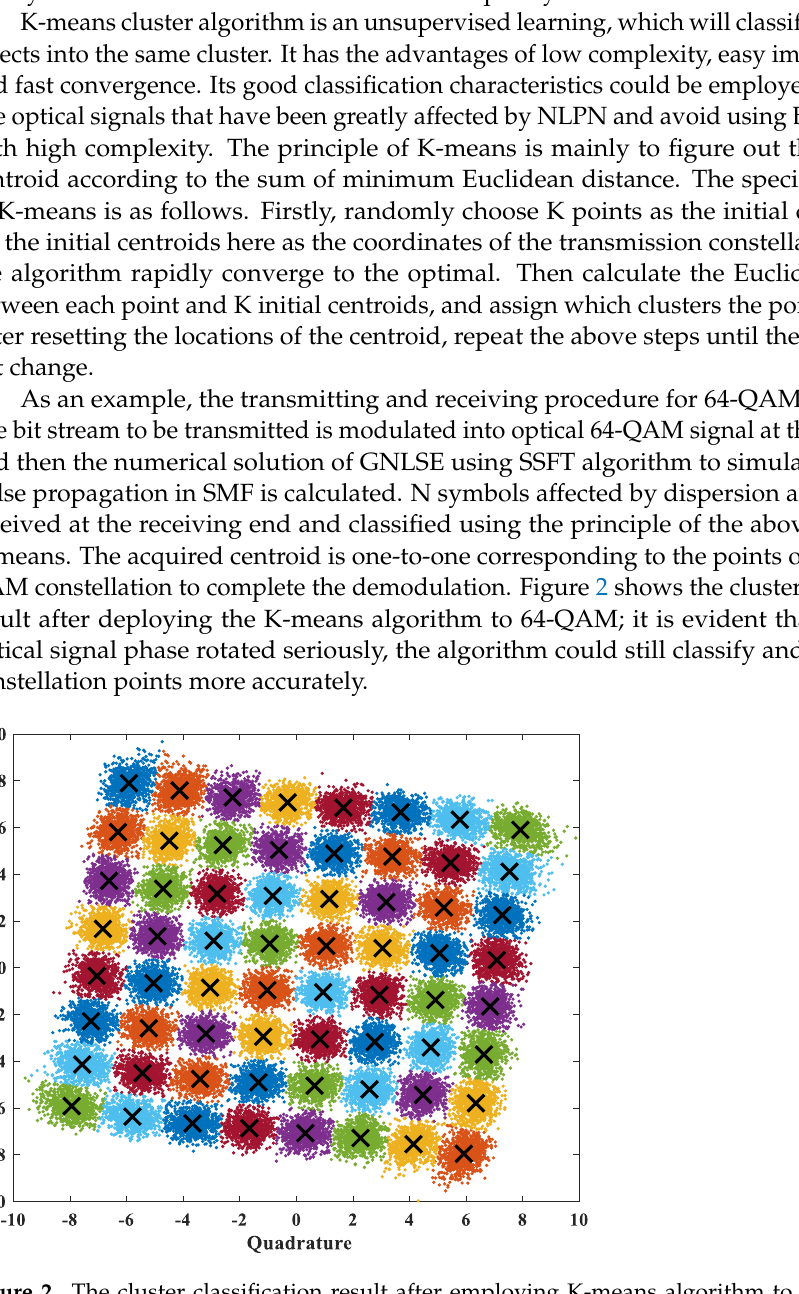
Figure 2. The cluster classification result after employing K-means algorithm to 64QAM; black intersections: ideal constellation points under impacting by NLPN (associated centroids); colored dots: the signals in the cluster associated with the nearest black intersections.